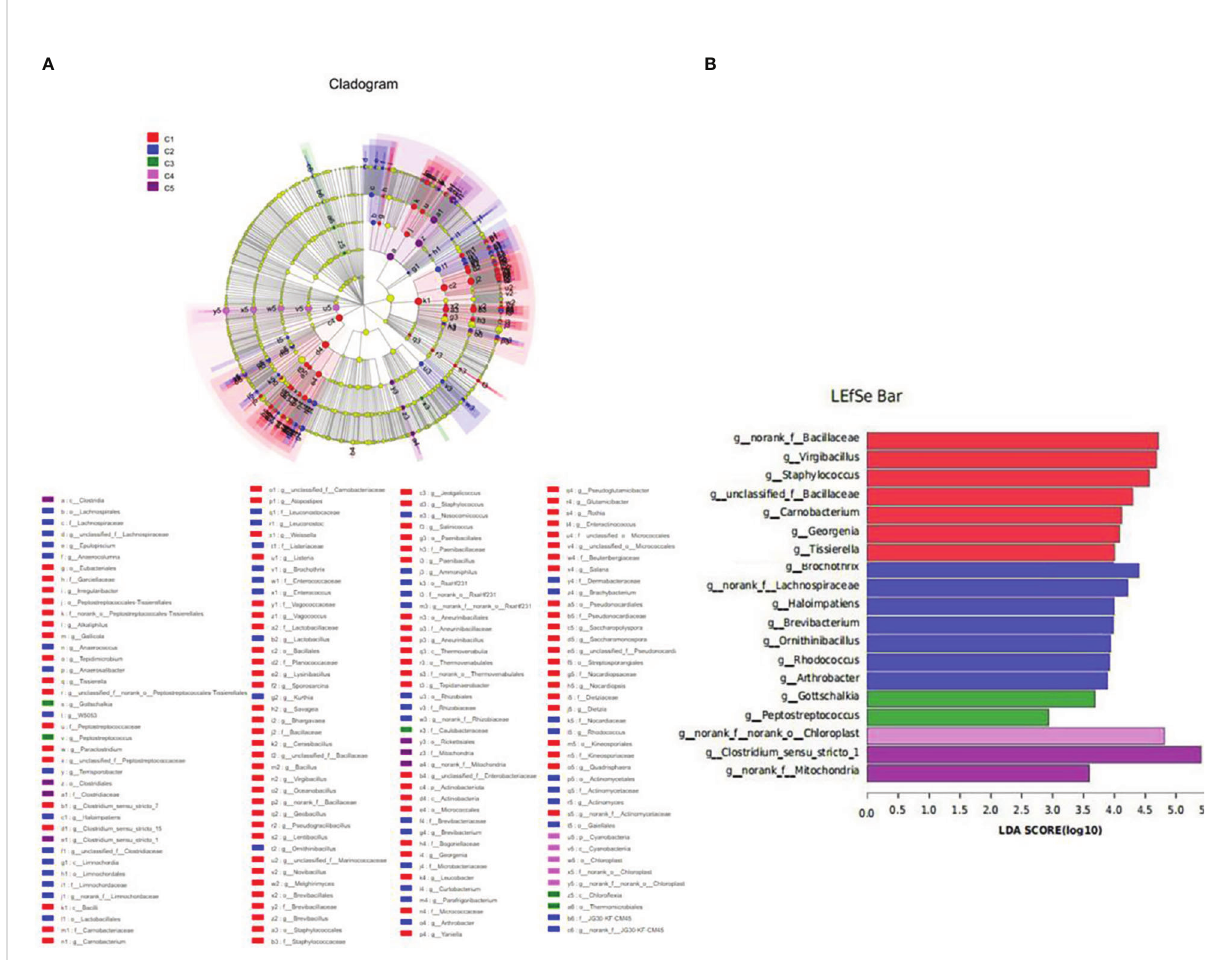
FIGURE 9 Inter-group variation in the relative abundance of intestinal microbial communities at the genus level. (A) Cladogram from Lefse. (B) LDA score from